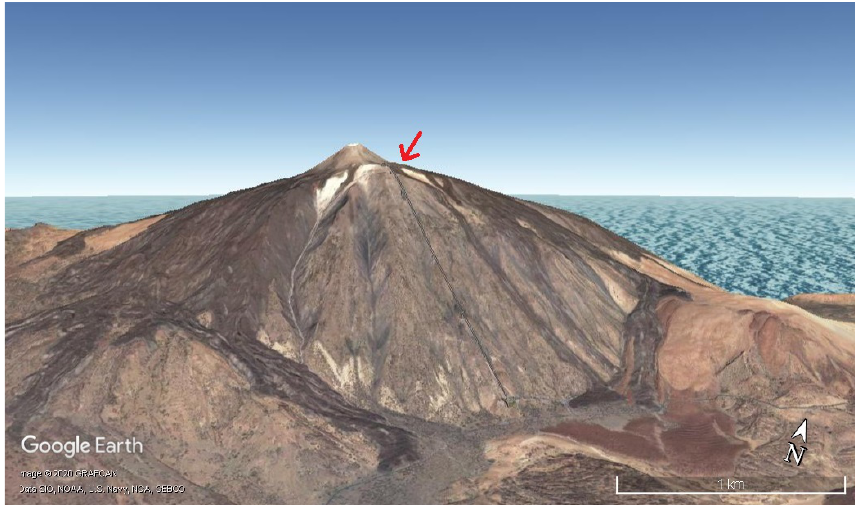
Figure 6. Location of the installed prototype closed to “La Fortaleza” lookout. c (cid:13) Google Earth.